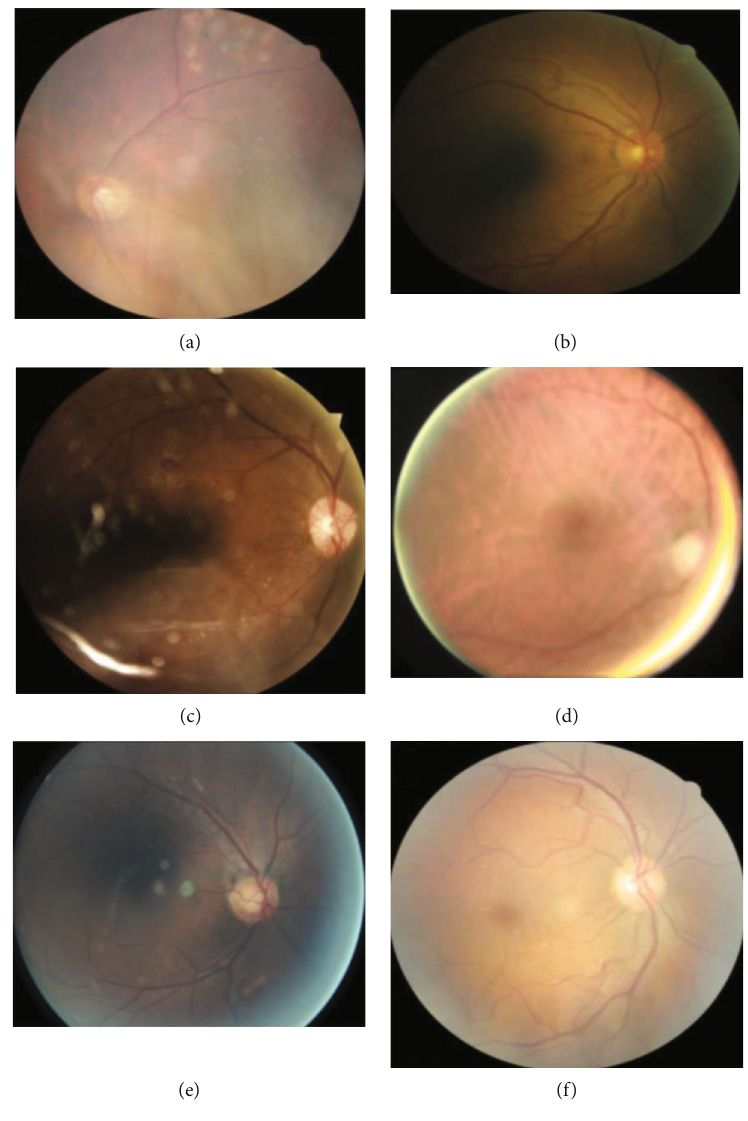
Figure 6: Images in the Kaggle dataset with wrong prediction. (a) False-negative in an image with foggy view and retinal laser scar. (b) False- negative in an image with poor illumination. (c) False-negative in an image with re fl ective spots and shadows. (d) False-positive in an image with overexposure and halo. (e) False-positive in an image with underexposure and halo. (f) False-positive in an image with exudates caused by age-related macular